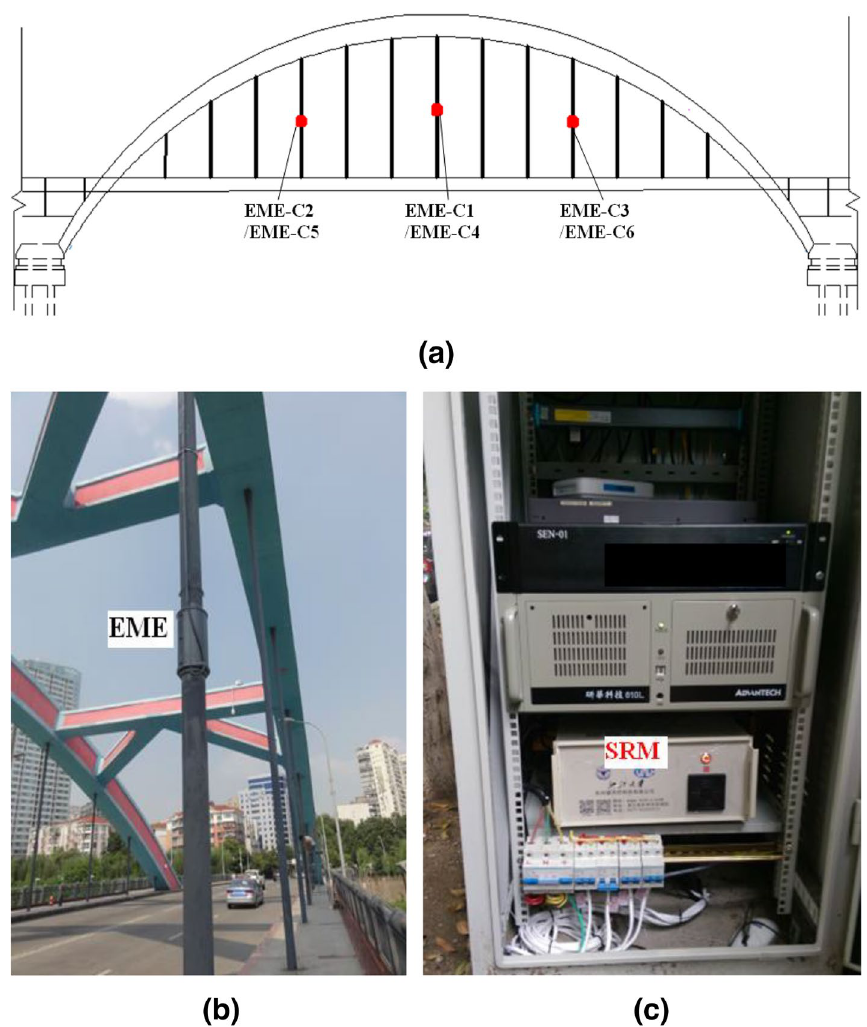
Fig. 6 EME sensors and SRM for long-term monitoring in the arch bridge: a Layout of EME sensors, b installed EME sensor, and c